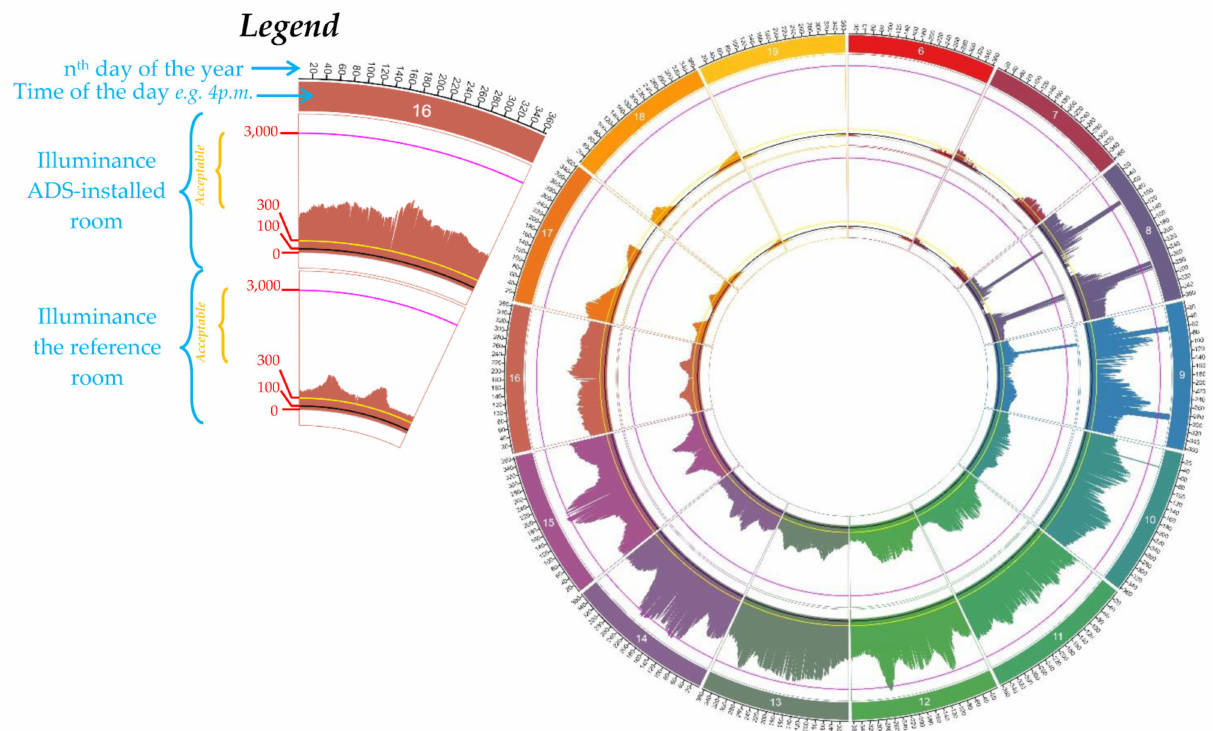
Figure 13. A yearly measurement and comparison between the reference room and ADS-installed daylight illuminance on an hourly